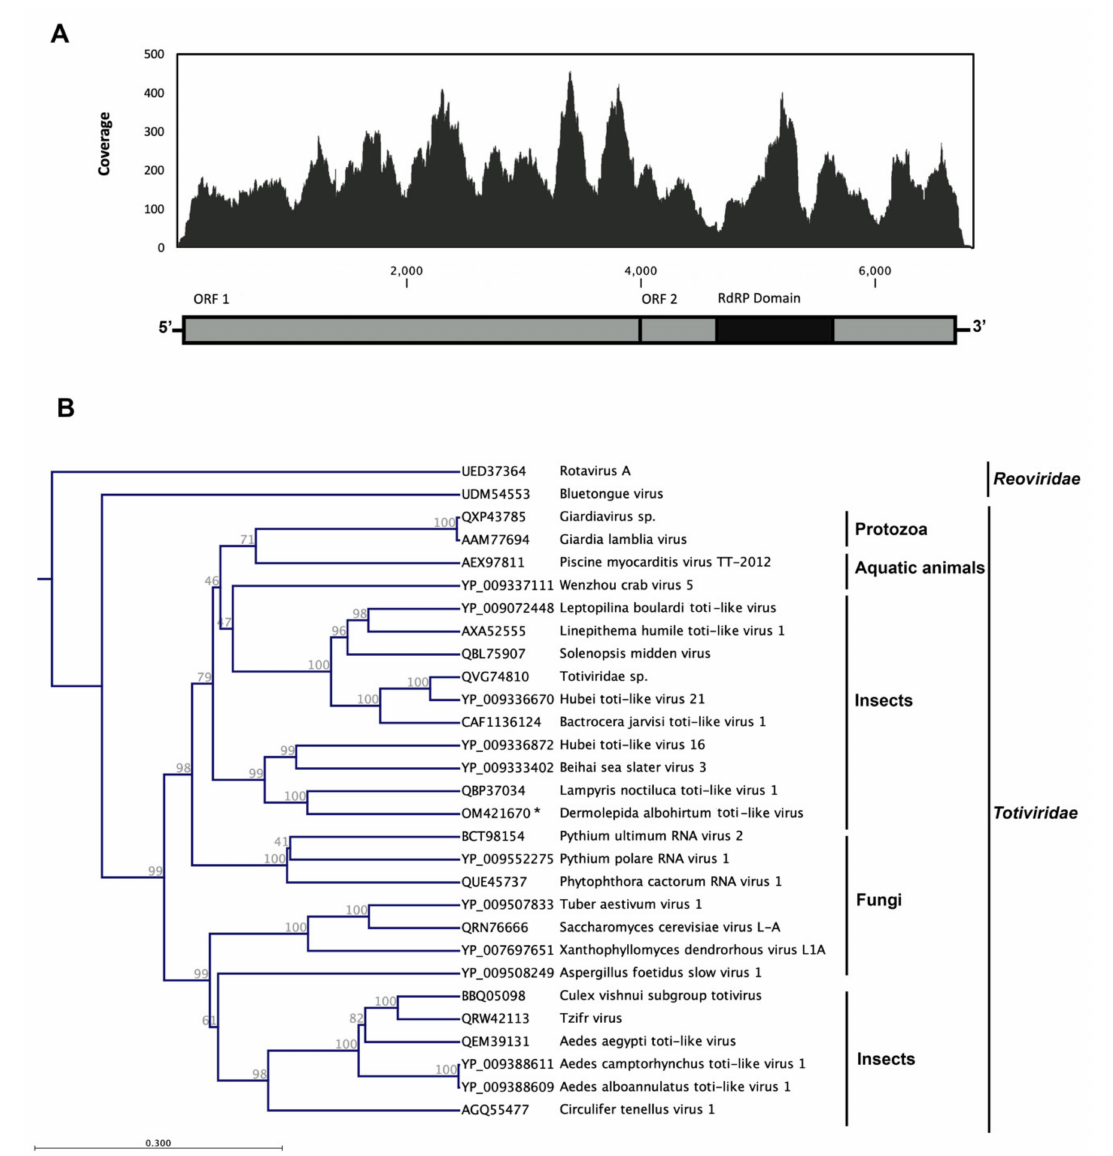
Figure 3. Schematic of the genome organization and coverage of greyback canegrub toti-like virus. The conserved structural domains were identified through a Pfam domain search. RNA-Seq read density plotted along the viral genome. The Y -axis shows the number of reads mapped to a particular nucleotide of the virus genome at the X -axis ( A ). The maximum likelihood phylogeny of Dermolepida albohirtum toti-like virus (DaTV1) and previously reported viruses in family Totiviridae based on deduced amino acid sequence of conserved RdRP domain. We used two members of family Reoviridae as outgroups in this analysis. The novel DaTV1is clustered with other members of this family which previously reported from insects and other arthropods. The identified virus in this study is shown with an asterisk ( B